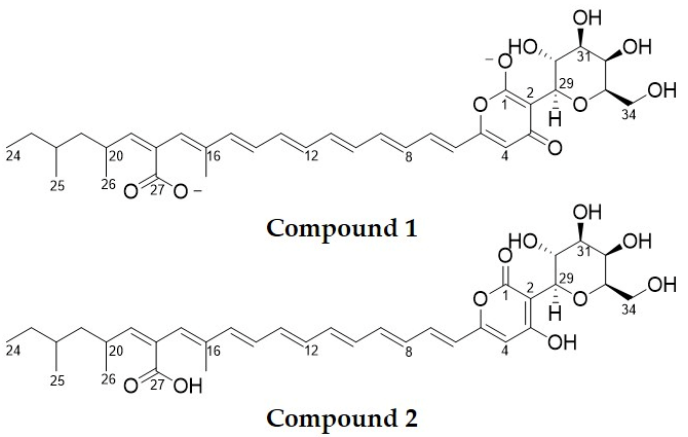
Figure1. Chemicalstructureofthepurifiedyellowantifungalcompound(compound 1 )andepipyroneA (compound 2 ). The purified yellow antifungal compound is a disalt of epipyrone